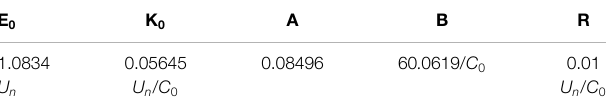
TABLE 1 | Parameters of the constant current-constant voltage two-stage variable power charging process of the lithium battery.